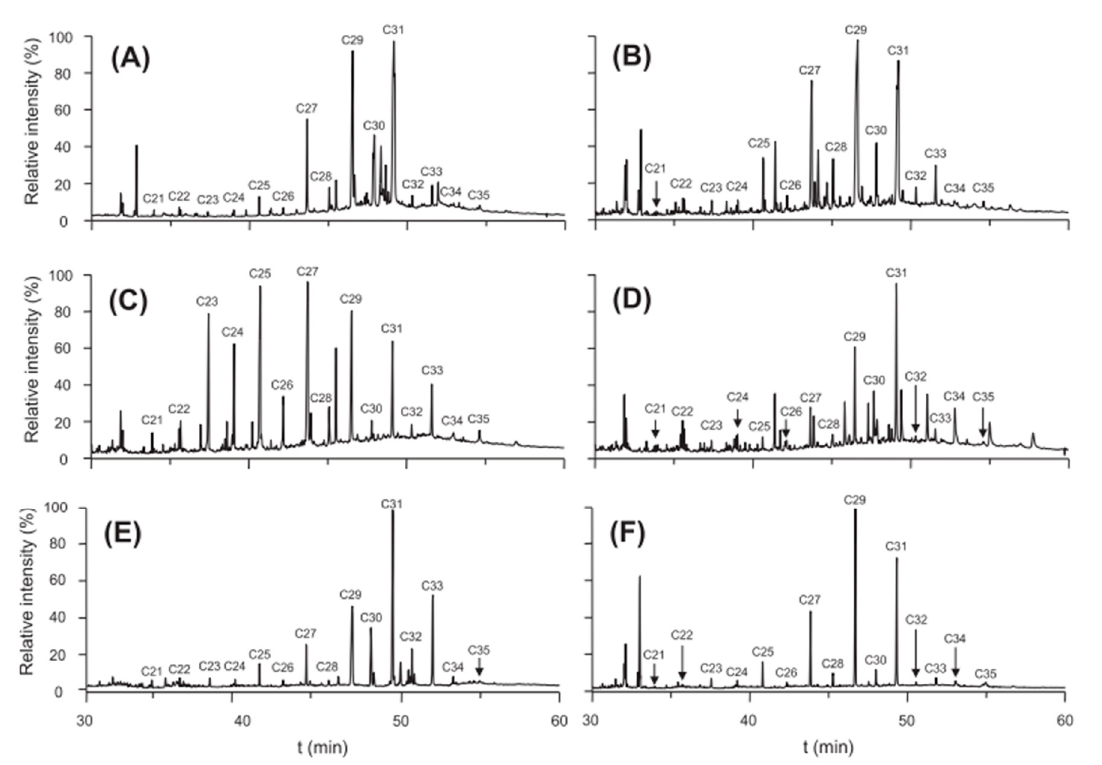
Figure 2. GC-MS chromatograms of di ff erent vegetable oils: ( A ) grapeseed oil, ( B ) hazelnut oil, ( C ) olive oil (Arbequina), ( D ) peanut oil, ( E ) corn oil and ( F ) sunflower. Reference [3] with permission from